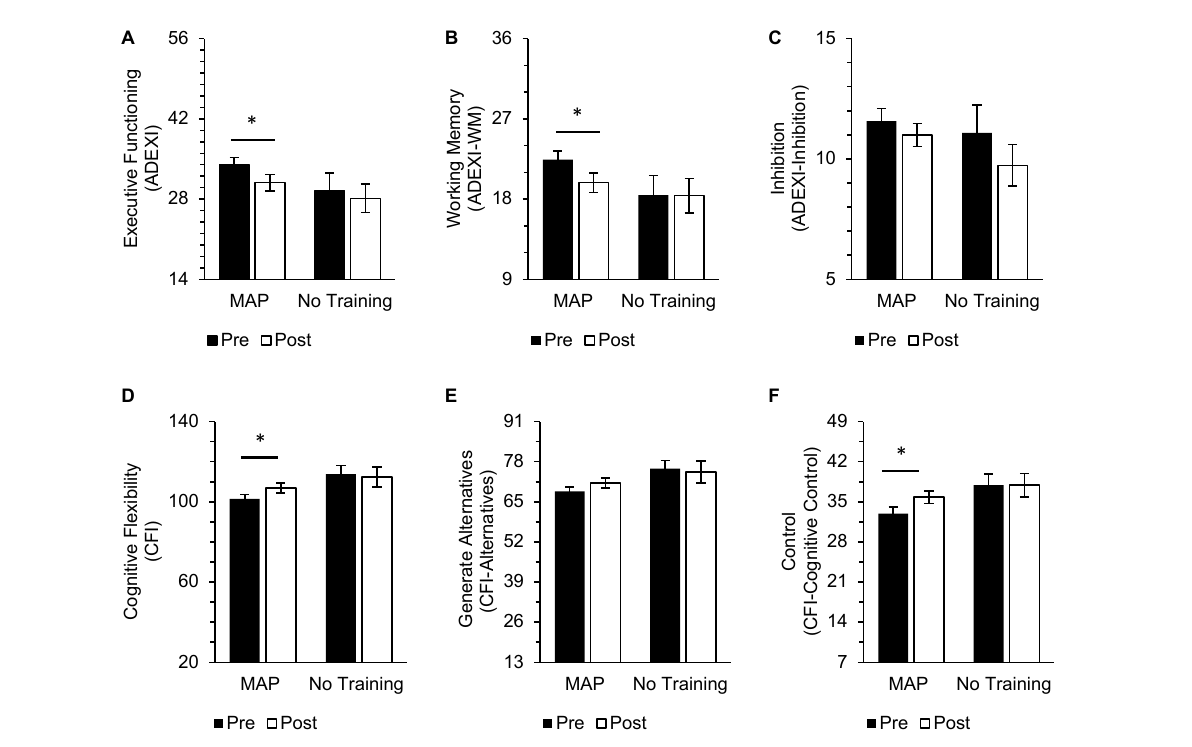
FIGURE6 In the MAP group, post-intervention scores on measures of executive functioning [ (A) ADEXI] and working memory [ (B) ADEXI-WM], cognitive flexibility [ (D) CFI], and cognitive control [ (F) CFI-Control] were significantly improved from baseline. Participants in the MAP group did not report improvements in inhibition [ (C) ADEXI-Inhibition] or ability to generative alternatives [ (E) CFI-Alternatives]. There were no significant changes in self-reported cognitive functioning reported by participants in the No Training group. There were also no significant between-group differences in these domains at either timepoint. Asterisks indicate significant adjusted p -values. Total scores on the ADEXI range from 14 to 70, ADEXI-WM subscores range from 9 to 45, and ADEXI-Inhibition subscores range from 5 to